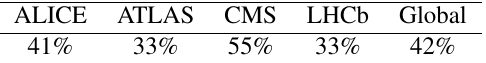
Table 1. Fraction of Tier-2 storage available over